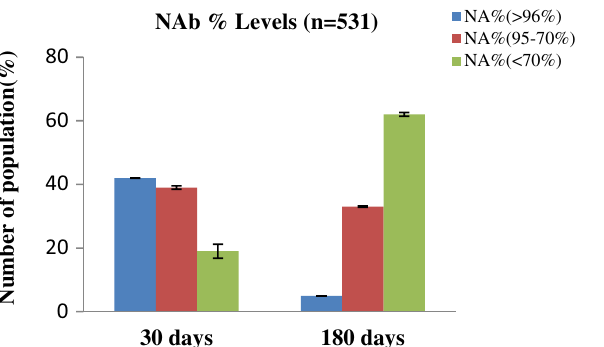
Figure 1. Percentage (%) of people with immune response on the basis of days, after 30 days and 180 days completing 2nd immunization.